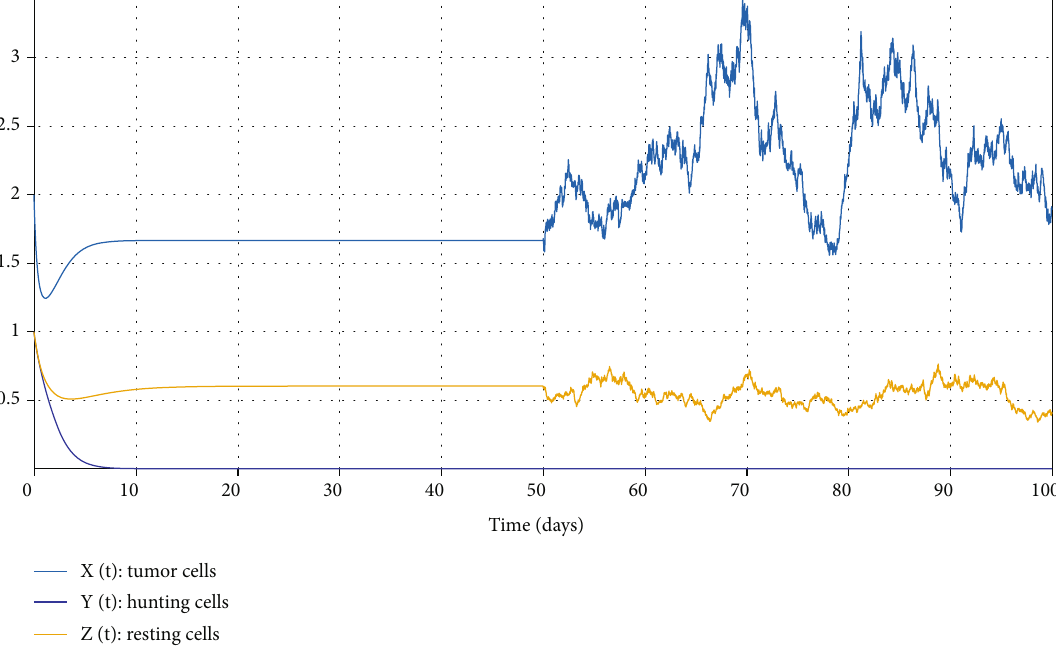
= 0 : 9 , c = 0 : 65 , c = 0 : 21 , c = 0 : 55 , c = 0 : 52 , c = 0 : 39 , c 1 2 3 4 5 6 7